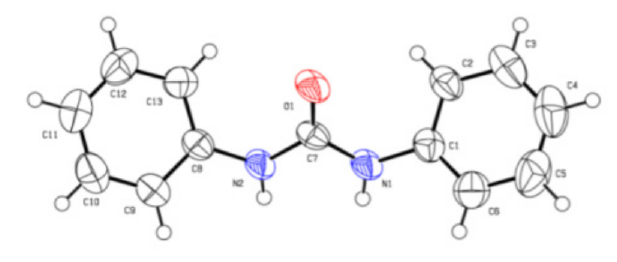
Figure 2. Crystal structure of 2a